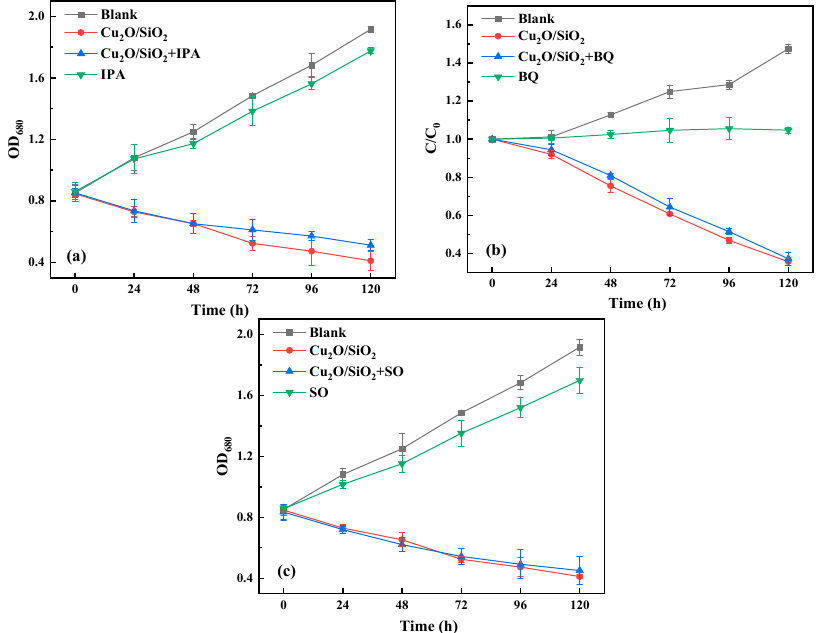
Figure 6. Active species trapping experiments. ( a ) ·OH; ( b ) ·O 2 − ; and, ( c ) h + .